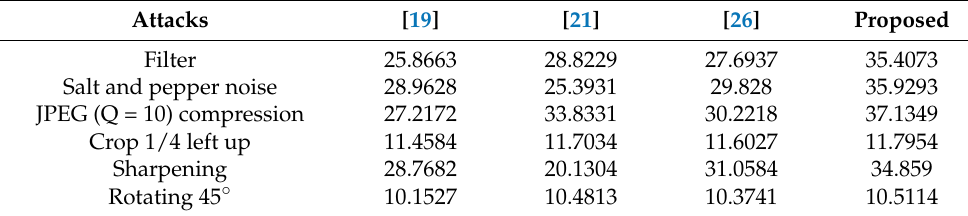
Table 5. PSNR values of different algorithms under attacks.